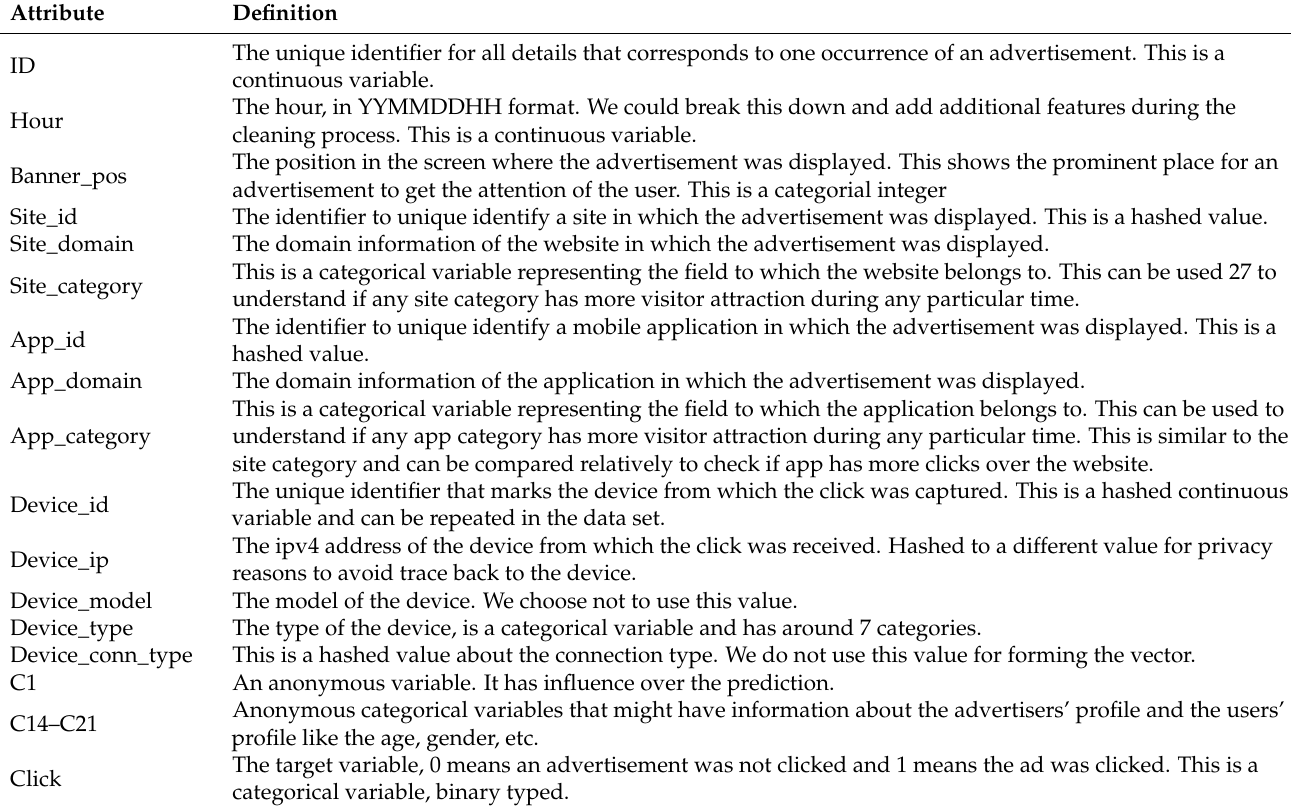
Table 7. Features in the Avazu click-through rate prediction